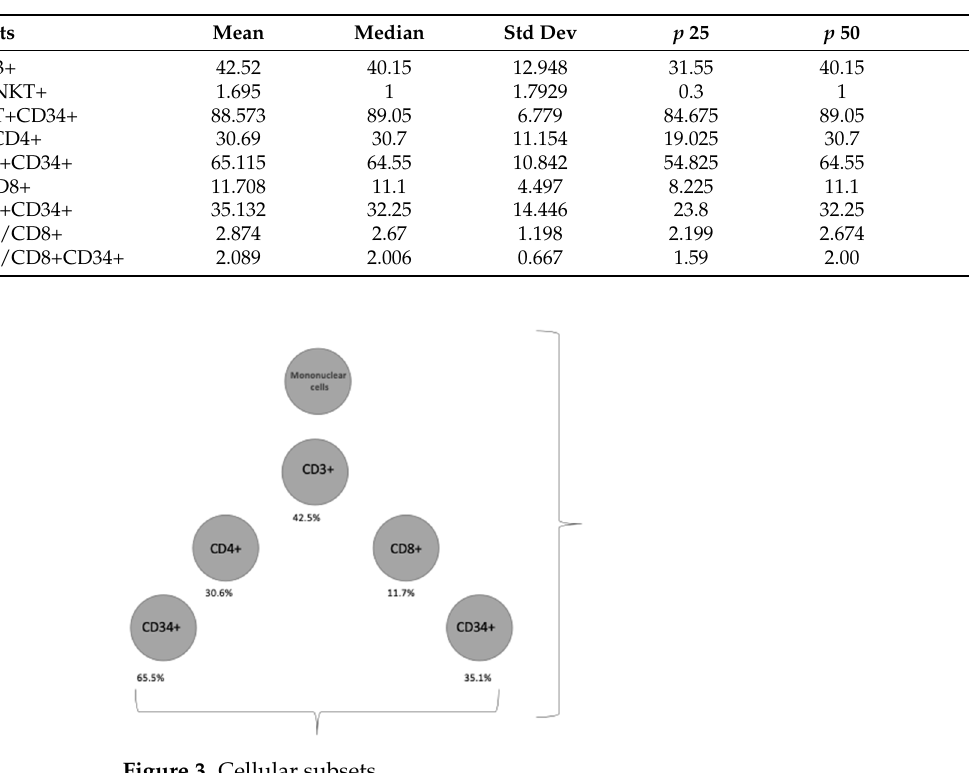
Table 9. Lymphocyte subset proportions.